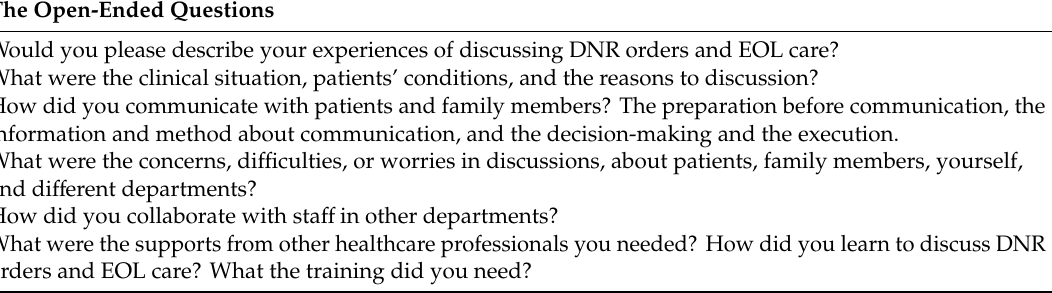
Table A1. The open-ended